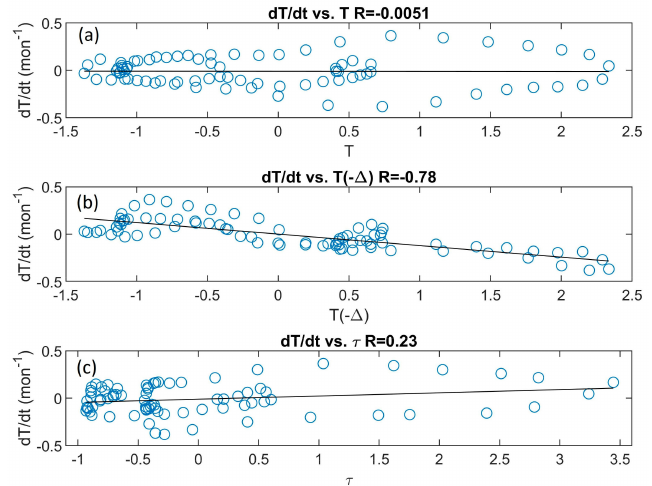
Figure 4. The relationship of the rate of change of temperature (dT / dt) to un-delayed temperature ( a ), delayed temperature ( b ), and the normalized wind stress, τ ( c